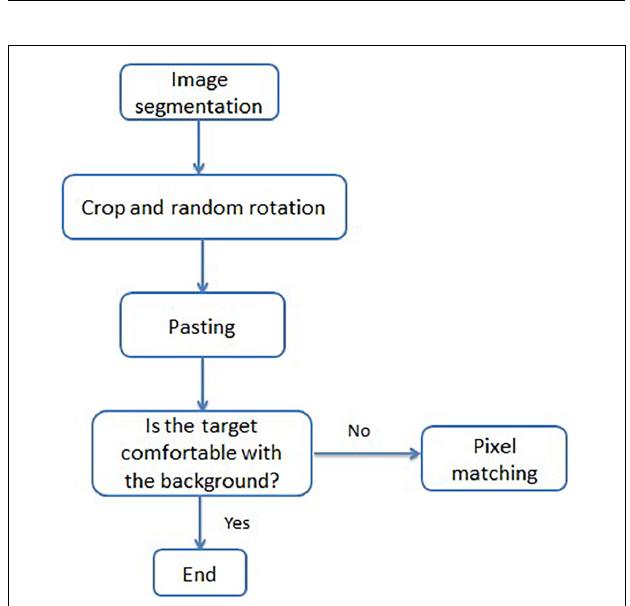
FIGURE 2 | Diagram of the relationship between the picture and the target quantity.